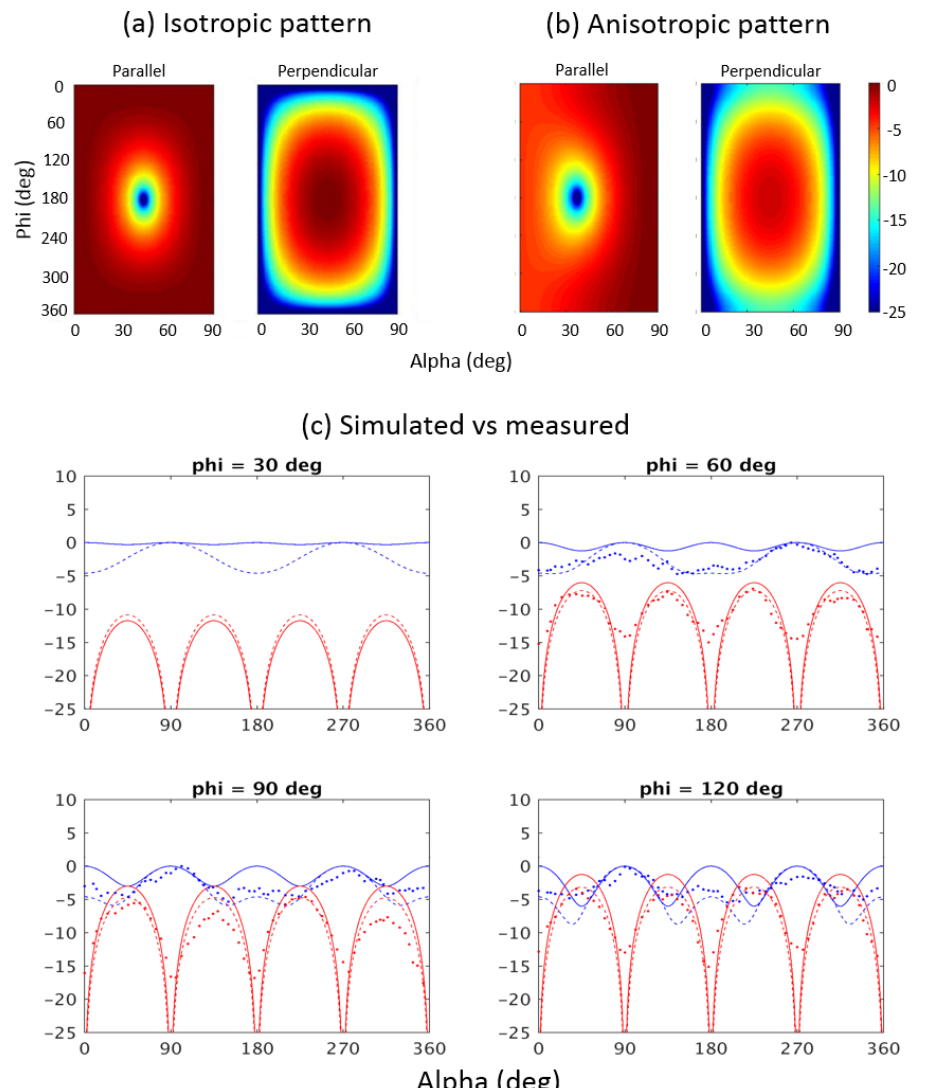
Figure 4. Effects of the angle α between TX1 and x axis and birefringence phase shift ∅ on isotropic and anisotropic reflected power. The color bars in panels (a) and (b) give the power scale in the range from 0 to − 25dB. In panel (c) , the blue and red lines correspond to co-polarization and cross-polarization, respectively; the solid lines are simulated isotropic pattern, dashed lines are simulated anisotropic pattern, and dotted lines are filtered measurements along Circle